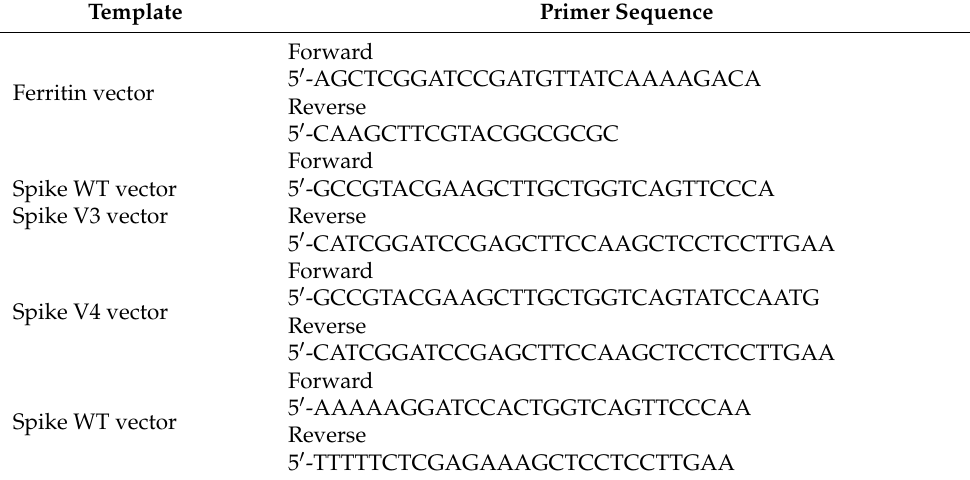
Table 1. List of primers used in this